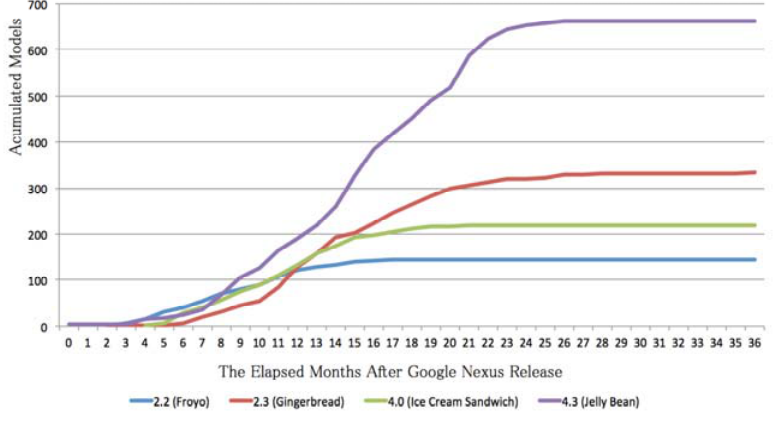
Figure 2. The model release of 10 Android smartphone manufacturers Source: Authors’ analysis based on the data from